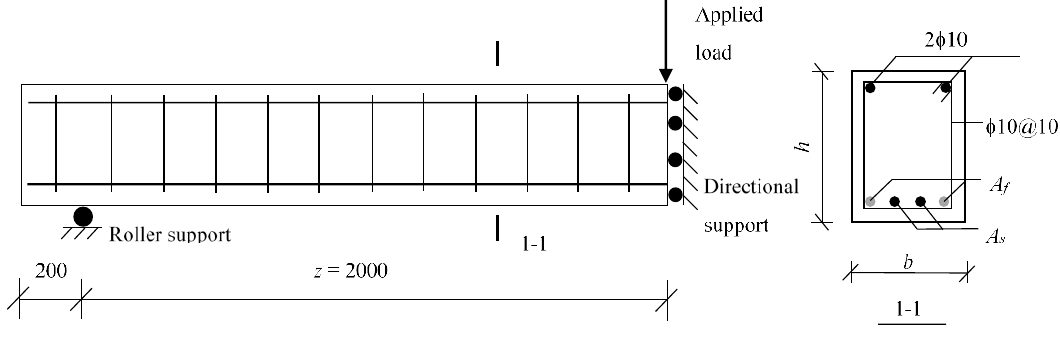
Figure 4. Details of control beam (unit: mm).